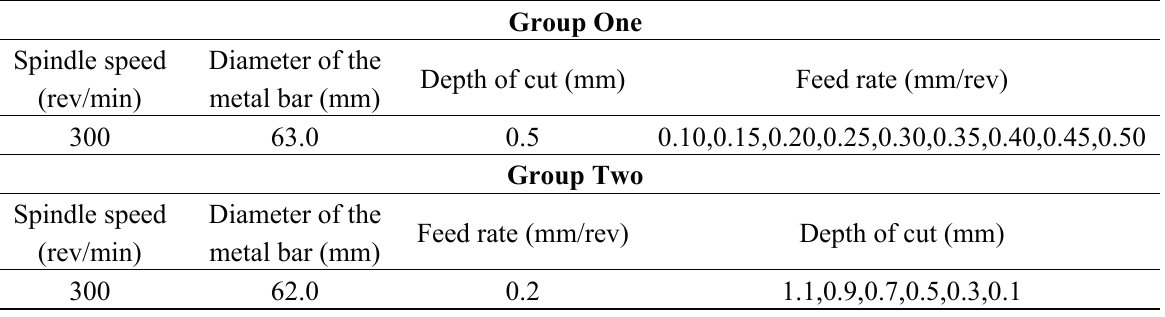
Table 1. Experiment parameters of turning operation.